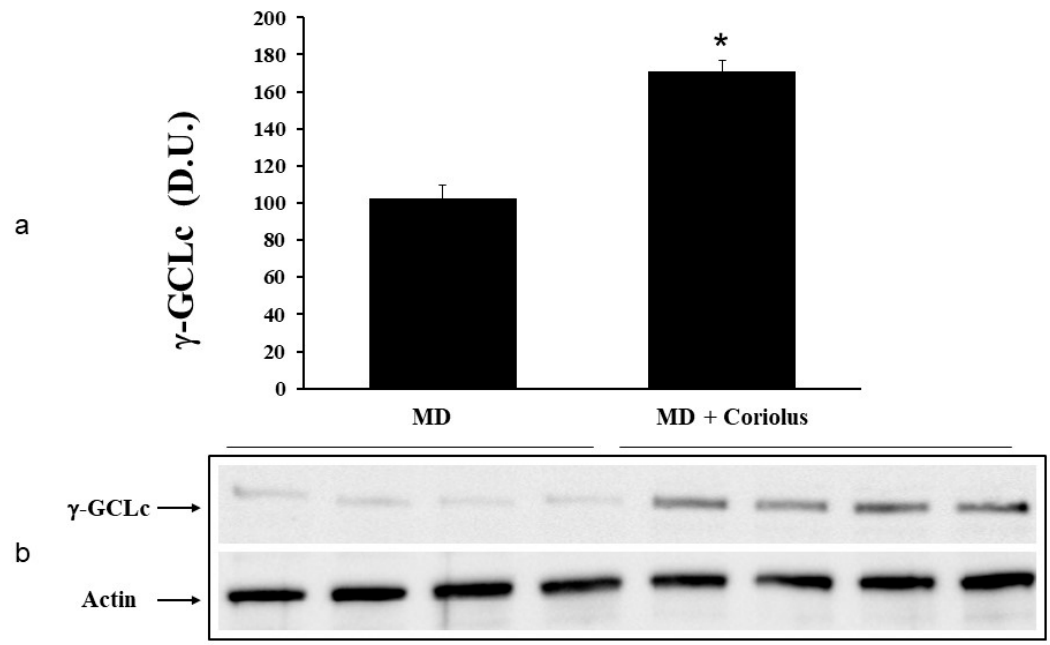
Figure 6. γ -GC liase levels in lymphocytes from MD patients. Plasma samples from MD patients were assayed for γ -GC liase by western blot as described in Materials and Methods. A representative immunoblot is shown ( b ). β -actin has been used as loading control. The bar graph shows the densitometric evaluation and values are expressed as mean ± SEM of independent analyses on 22 patients (MD plus Coriolus biomass) and, respectively, on 18 patients (MD alone), per group ( a ). * p < 0.05 vs. MD alone. D.U., densitometric units.